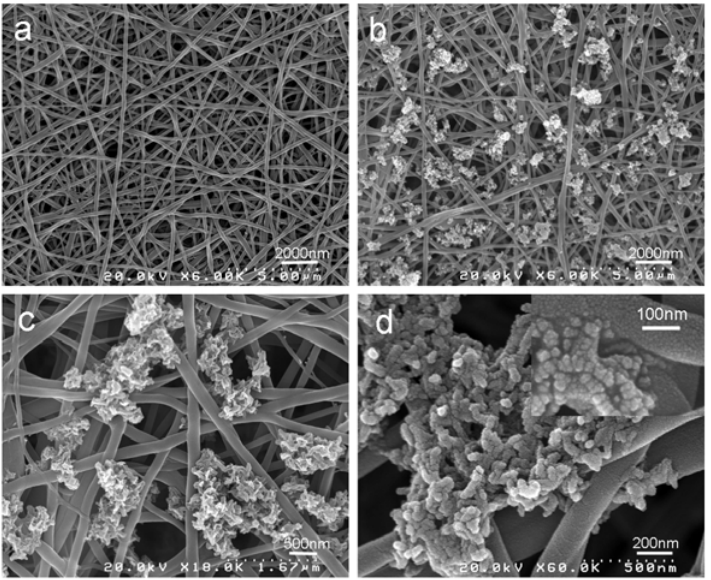
Figure 7. FE-SEM images of pure silk and mineralized silk/nano-hydroxyapatite (nHA) nanofibers after 3 cycles of Ca–P treatment. ( a ) pure silk nanofibers (6,000×; scale bar, 500 nm); ( b–d ) mineralized silk/nHA nanofibers after 3 cycles of Ca–P treatment with different